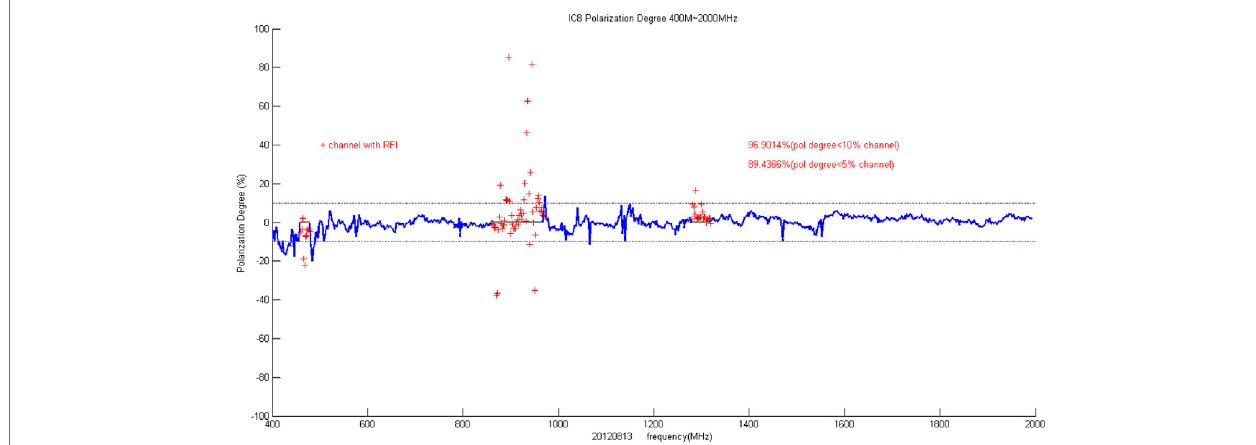
FIGURE4 | Polarization degree, or ( P L − P R ) / ( P L + P R ) ofa MUSER-I antenna element (IC8) in 400 – 2000 MHz range measured on 13Aug 2012,which is ≤ 10% over 96.9% whole frequency band, and furthermore, ≤ 5% over 89.4% whole frequency band. The red plus sign indicates frequency point where strong RFI occurred (Yan et al.,